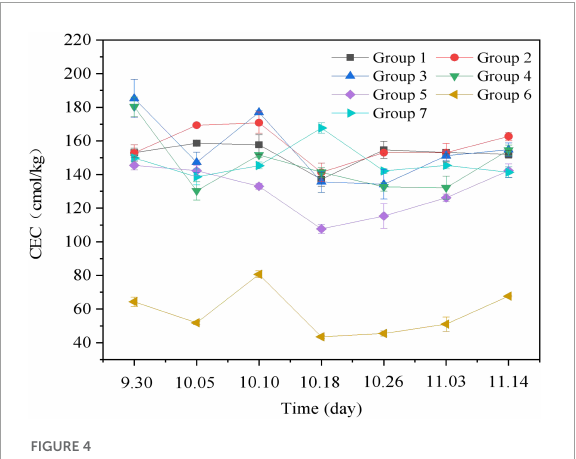
FIGURE4 Changes of cation exchange capacity (CEC) during the aerobic composting progress. The brief description of the symbols in the figures were similar with Figure 1 .